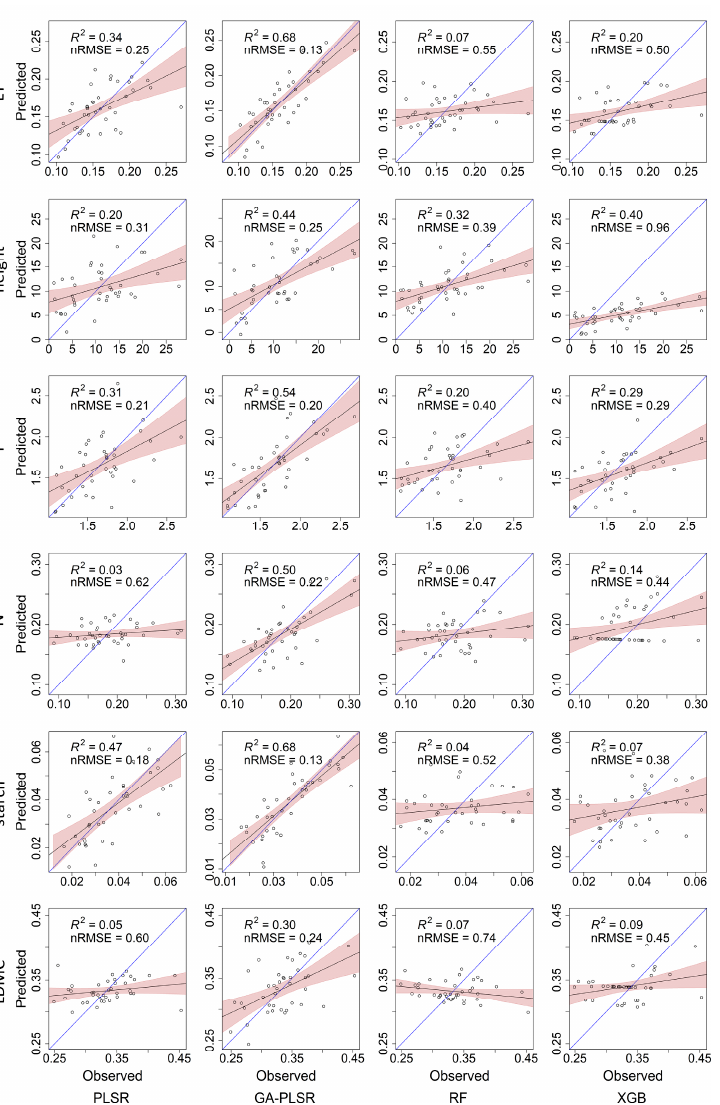
Figure 4. Predicted versus observed chlorophyll a (chl_a), chlorophyll b (chl_b), carotenoid (carot), specific leaf area (SLA), leaf thickness (LT), plant height (height), phosphorus content (P), starch content (starch), leaf dry matter content (LDMC) and nitrogen content (N) from PLSR, GA-PLSR, RF and XGBoost; the blue line denotes the 1:1 line, and the red areas denote the 95% confidence